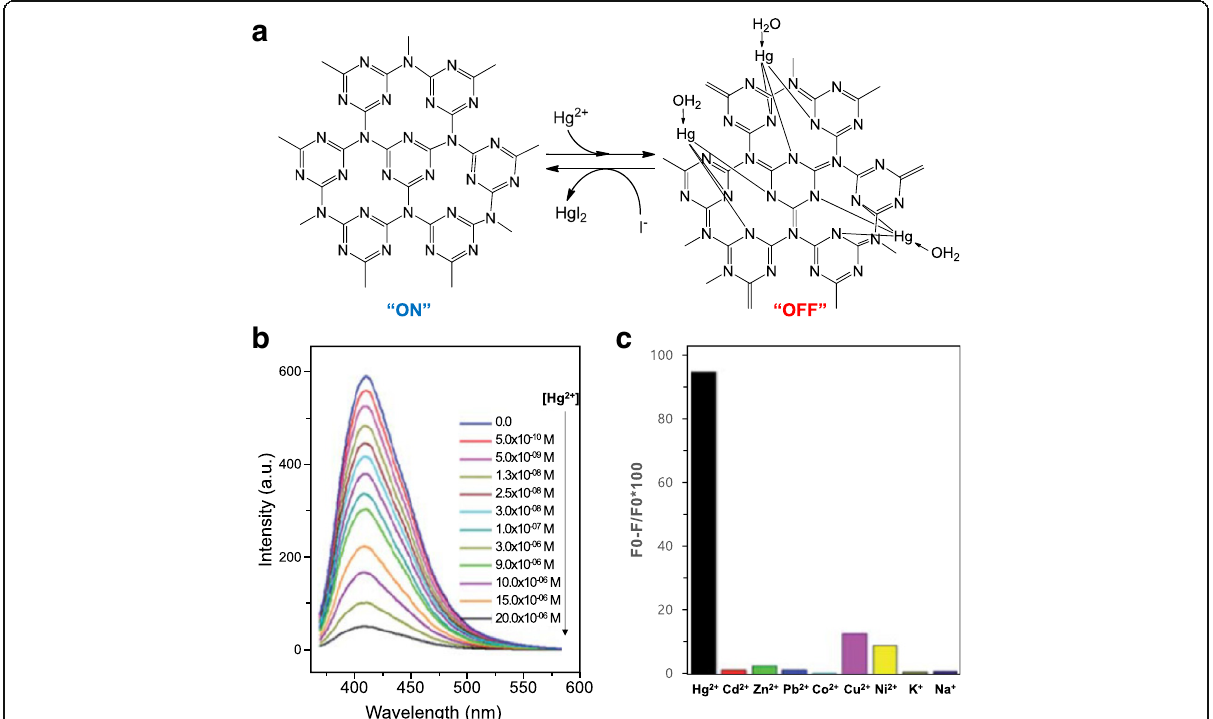
Fig. 8 a Schematic of N-doped graphene-(Hg 2+ ) complex and N-doped graphene on the addition of I-ions. b The change in the fluorescence emission of N-doped graphene (5 μ g L − 1 ) in water on the addition of Hg 2+ ions. c Fluorescence quenching of Hg 2+ ions compared to that of other metal ions